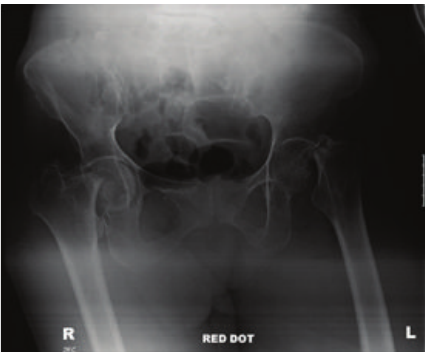
Figure 2: AP X-ray pelvis showing bilateral displaced intracapsular neck of femur